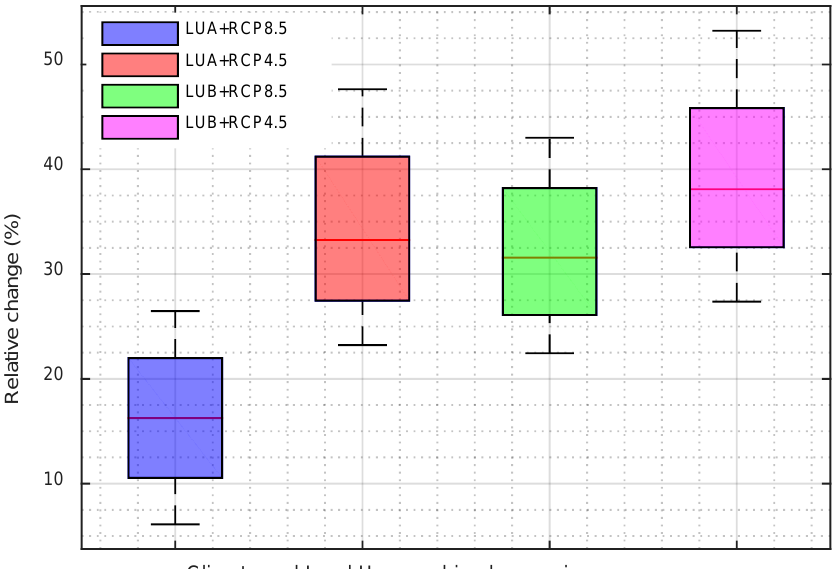
Figure 11. Annual total runoff change based on climate and land use combined scenarios. In each box, the central mark is the median, the edges of the box are the 25th and 75th percentiles and the whiskers extend to the most extreme data points not considered outliers.